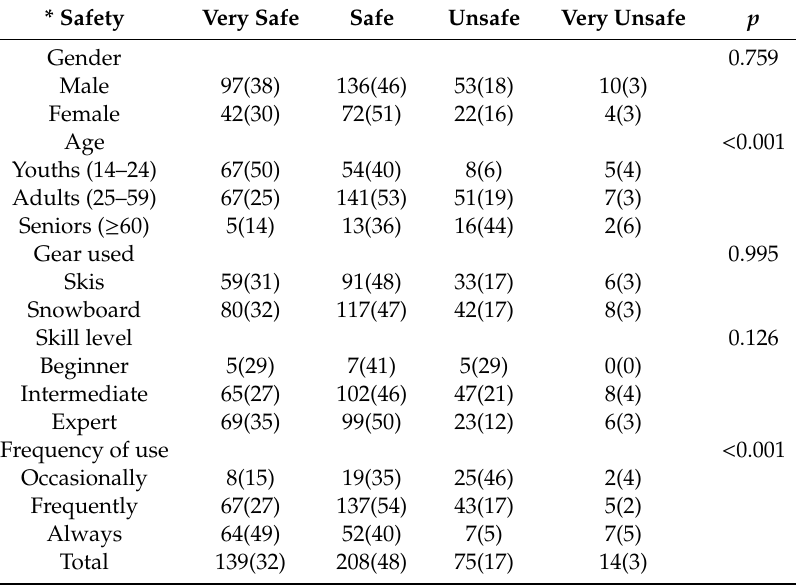
Table 4. Perception of safety among survey participants.